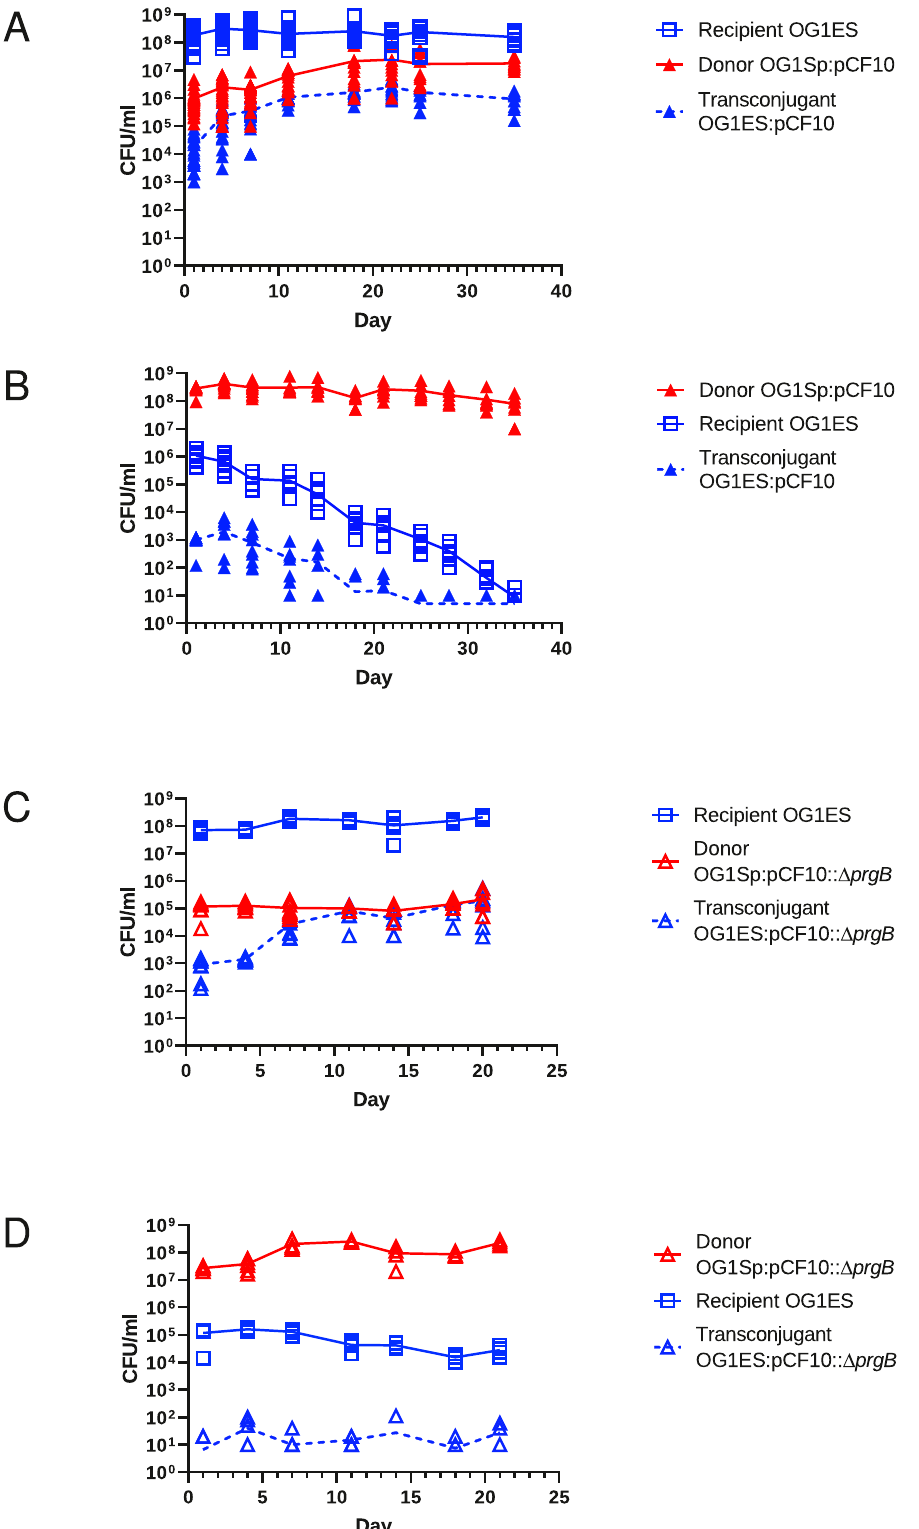
the 10 5 cells observed on day 1, (Fig. 1C). When OG1Sp:pCF10 Δ prgB compared to OG1Sp:pCF10 ( p < 0.001), with the fi nal community after 21 days harboring ~0.1% each of invading donors and trans- donors were established as residents (Fig. 1D), populations of resi- conjugants (Fig. 1C). This outcome shows the strong contribution of dents and invaders were equivalent to those observed in animals PrgB to the success of the invading pCF10-harboring strain and the harboring a resident recipient population invaded by Δ prgB donors positive impact of PrgB on the spread of pCF10 in the resident (Fig. 1C). In stark contrast to the elimination of the invading reci- recipient population. The donor population never increased above pient by wild-type pCF10 resident donors (Fig. 1B), resident NATURE COMMUNICATIONS| (2022) 13:1377 |https://doi.org/10.1038/s41467-022-29028-7|www.nature.com/naturecommunications